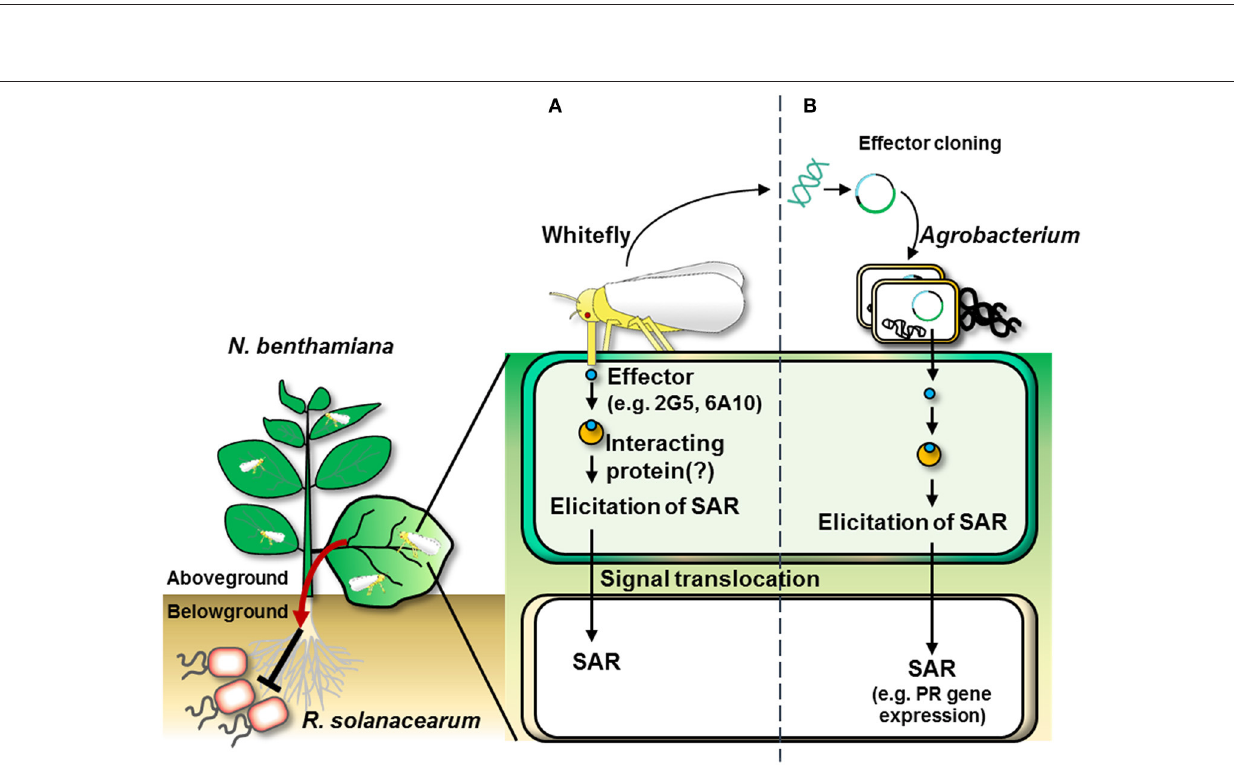
Frontiers in Ecology and Evolution | www.frontiersin.org